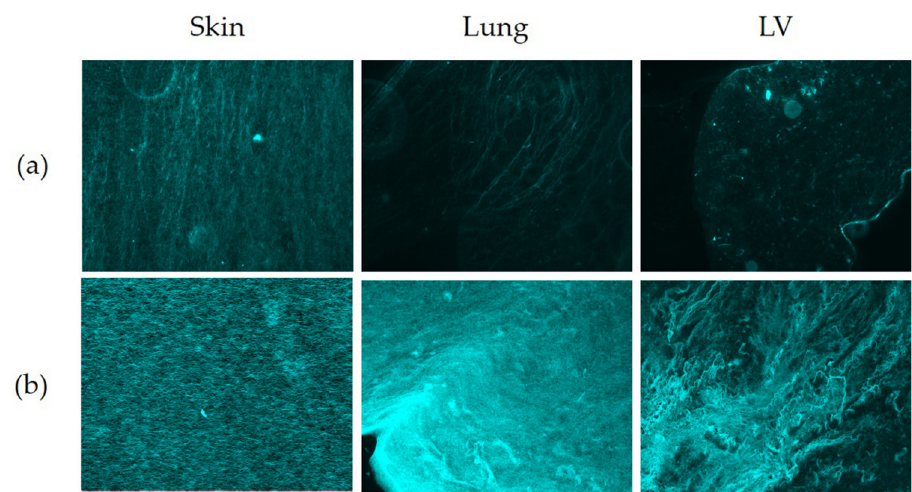
Figure 7. Immunohistochemistry (red) of COL1A1 and Elastin of skin, lung and LV ECM hydrogels. Scale bars represent 50 µm.